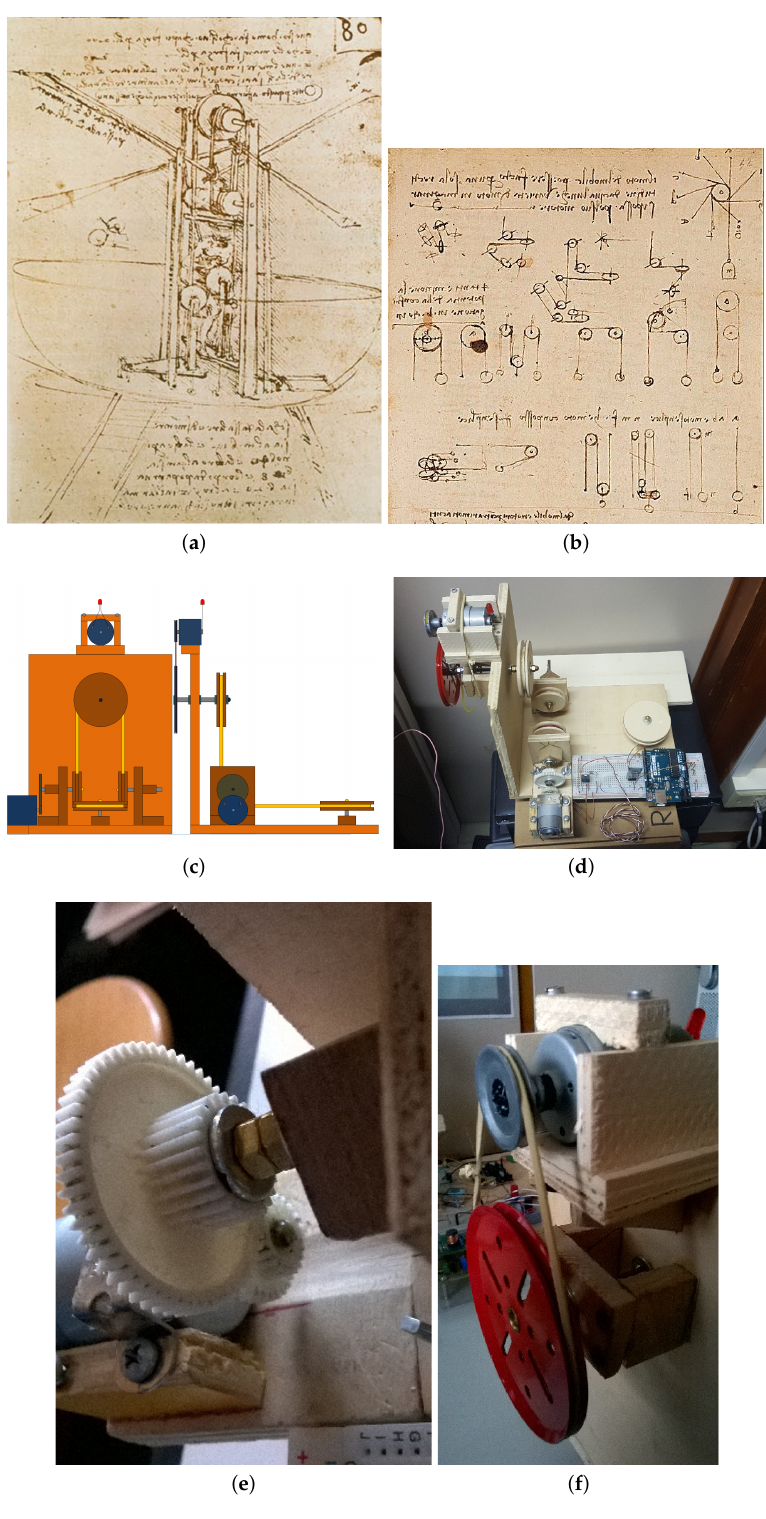
Figure 5. Machine 5, the Transformation of Motion: Leonardo studies for motion transformation ( a , b ); schematic of the setup for motion transformation ( c ); complete setup and particular of the motor actuation and of the dynamo ( d – f